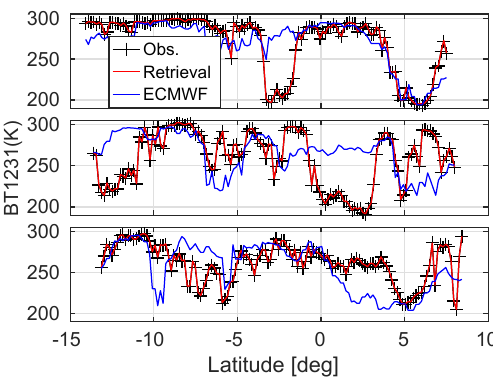
Figure 10. Three cross sections corresponding to the black lines in the granule image are shown. The curves are BT1231 cm − 1 comparisons between the observations (black) and ECMWF (blue), which show the hit or miss characteristics of the spatial placement of the model clouds. The red curve just shows that we can find and include nearby clouds in the ECMWF model that have simi- lar brightness temperatures to what is